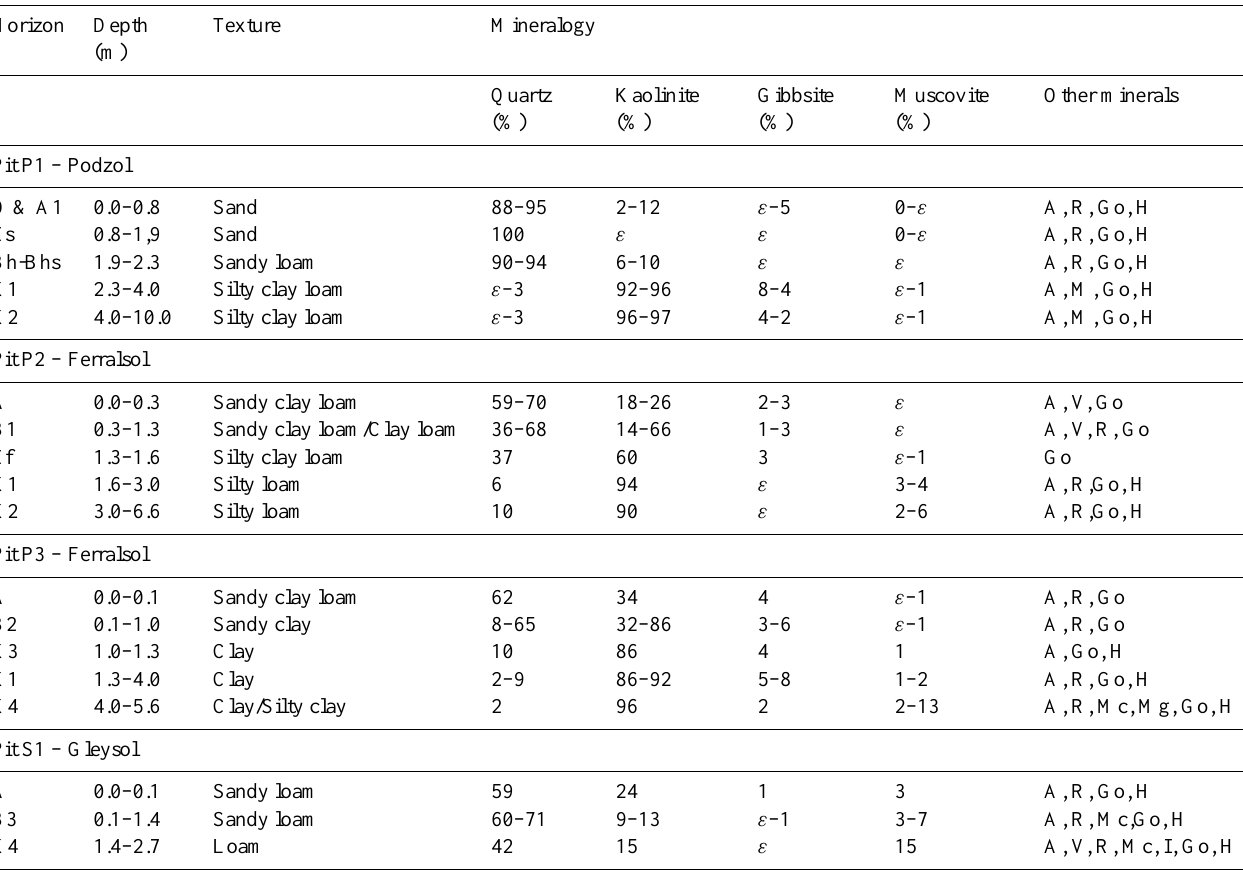
quartz grains and some red and yellow nodules appears at the mid-slope at the upper part of the kaolin body. Downslope, the K1 and K2 horizons give place to the K4 horizon char- acterized by more abundant unweathered muscovite and Fe red spots at its upper part. Gibbsitic nodules are located at the downslope half of the catena as indicated in the figure. In depth, C1 and C2 horizons are saprolitic horizons having many muscovite and weathered feldspar. At the lower part of the catena, the water table had the typical odor of